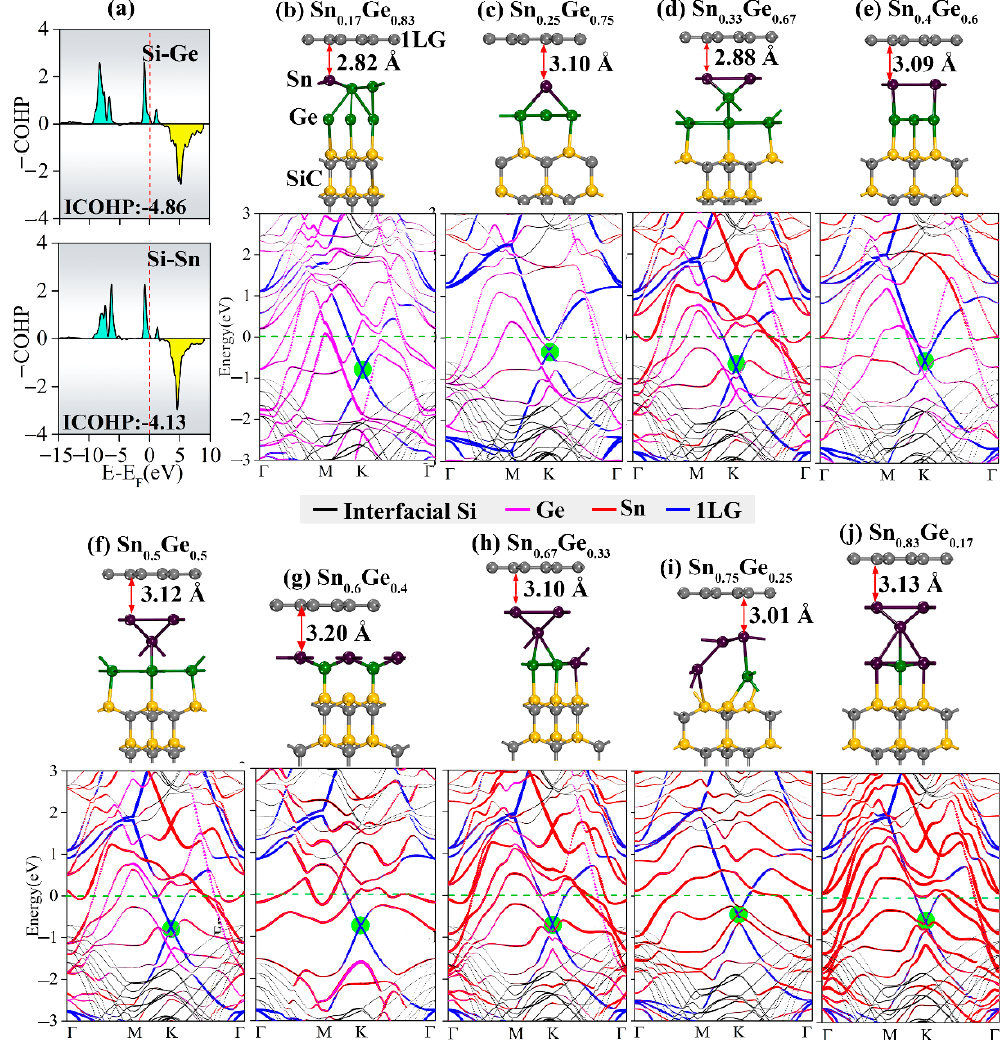
Figure 5. ( a ) ICOHP for the Ge or Sn interactions bonding with the Si atom in the SiC substrate. ( b – j ) Structures and band structures of Gr/ Sn 1 − x Ge x /SiC with the Sn:Ge ratios of 1/5, 1/3, 2/4, 2/3, 3/3, 3/2, 4/2, 3/1, and 5/1, respectively. In the band structures, the red, pink, blue and black lines represent the contribution of Ge intercalation, 1LG, and interfacial Si of SiC substrate, respectively. The green circles show the graphene Dirac point.